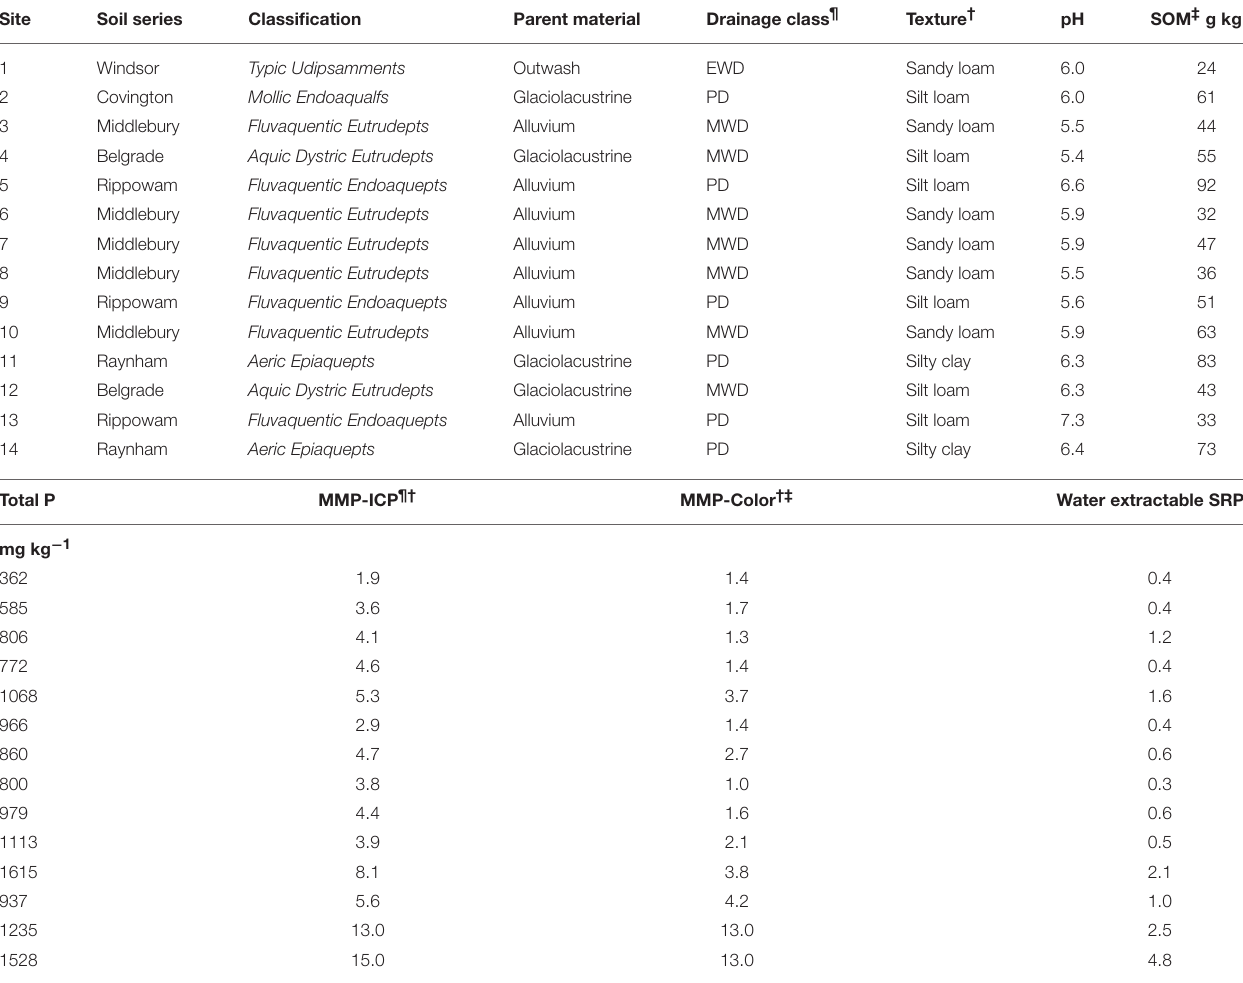
TABLE 1 | Soil and site characteristics for the samples used in the flooding